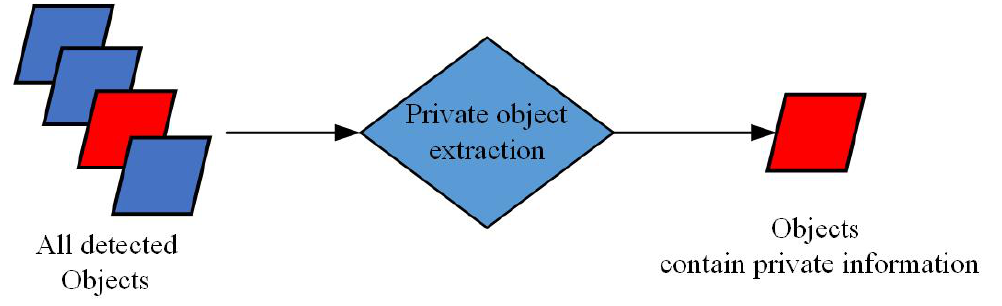
Figure 6. The diagram of private objects extraction part in our image de-identification (DE-ID)